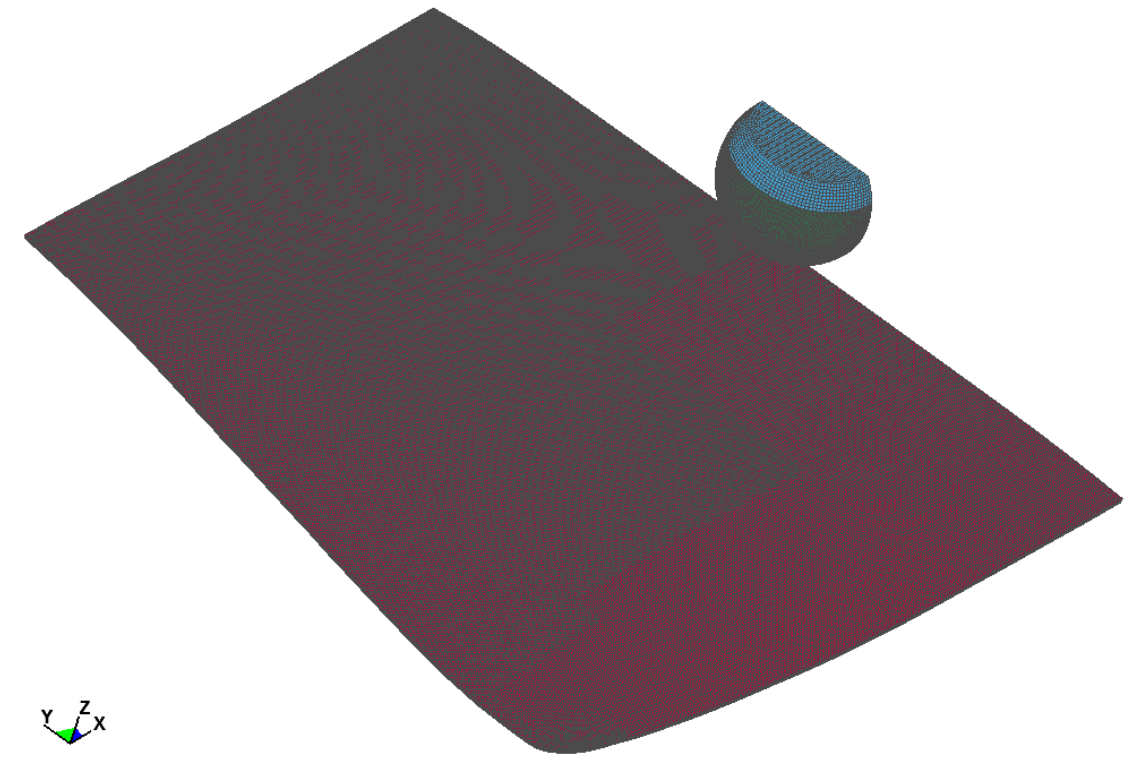
Figure 2. Strike of head impactor on the laminated windscreen — symmetrical model .